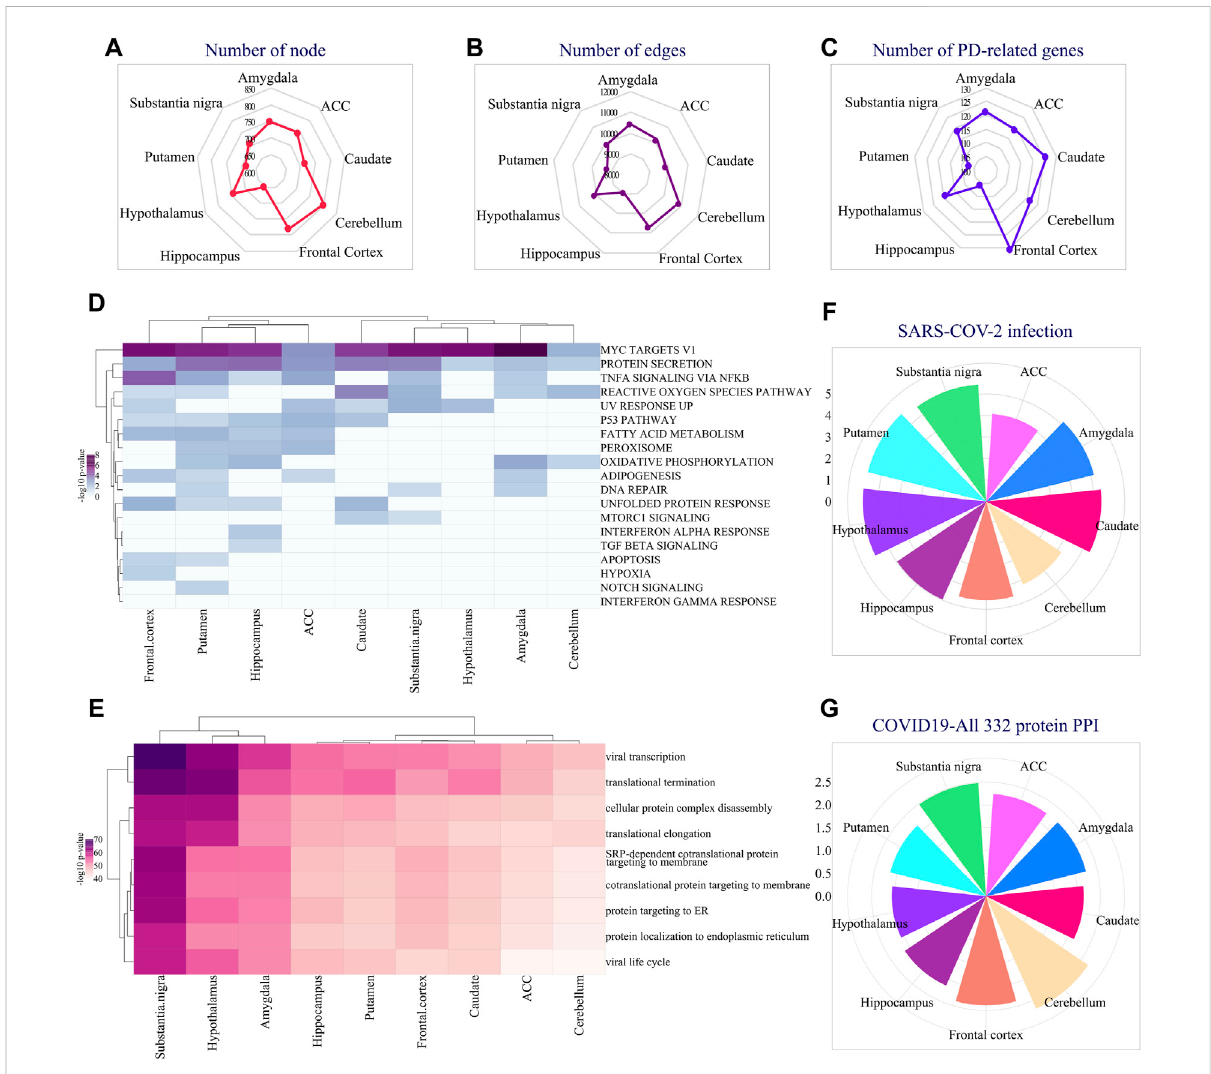
FIGURE 4 Analysis of region-speci fi c EASR genes co-expression networks. Radar plot demonstrating the number of (A) co-expression network ’ s nodes and (B) Edges in different brain regions. (C) Radar plot showing the number of PD-related genes present in each region ’ s speci fi c co-expression network. (D) Hallmarkpathwayenrichmentanalysisofco-expressionnetwork,acrossall9brainregions,illustratedbyheatmapof-log10adj p -value. (E) GO: BP enrichment analysis of co-expression network, across all 9 brain regions, illustrated by heatmap of -log10 adj p -value. Also, the “ COVID-19 Related Gene Sets 2021 ″ enrichment analysis represented all EASR co-expression networks enriched for some important COVID-19 related terms, such as (F) Genes whose expression is altered by SARS = COV-2 infection, and (G) “ COVID19-All 332 protein host PPI ” gene sets. F-G circular bar plots demonstrating -log10 adj p -value of each